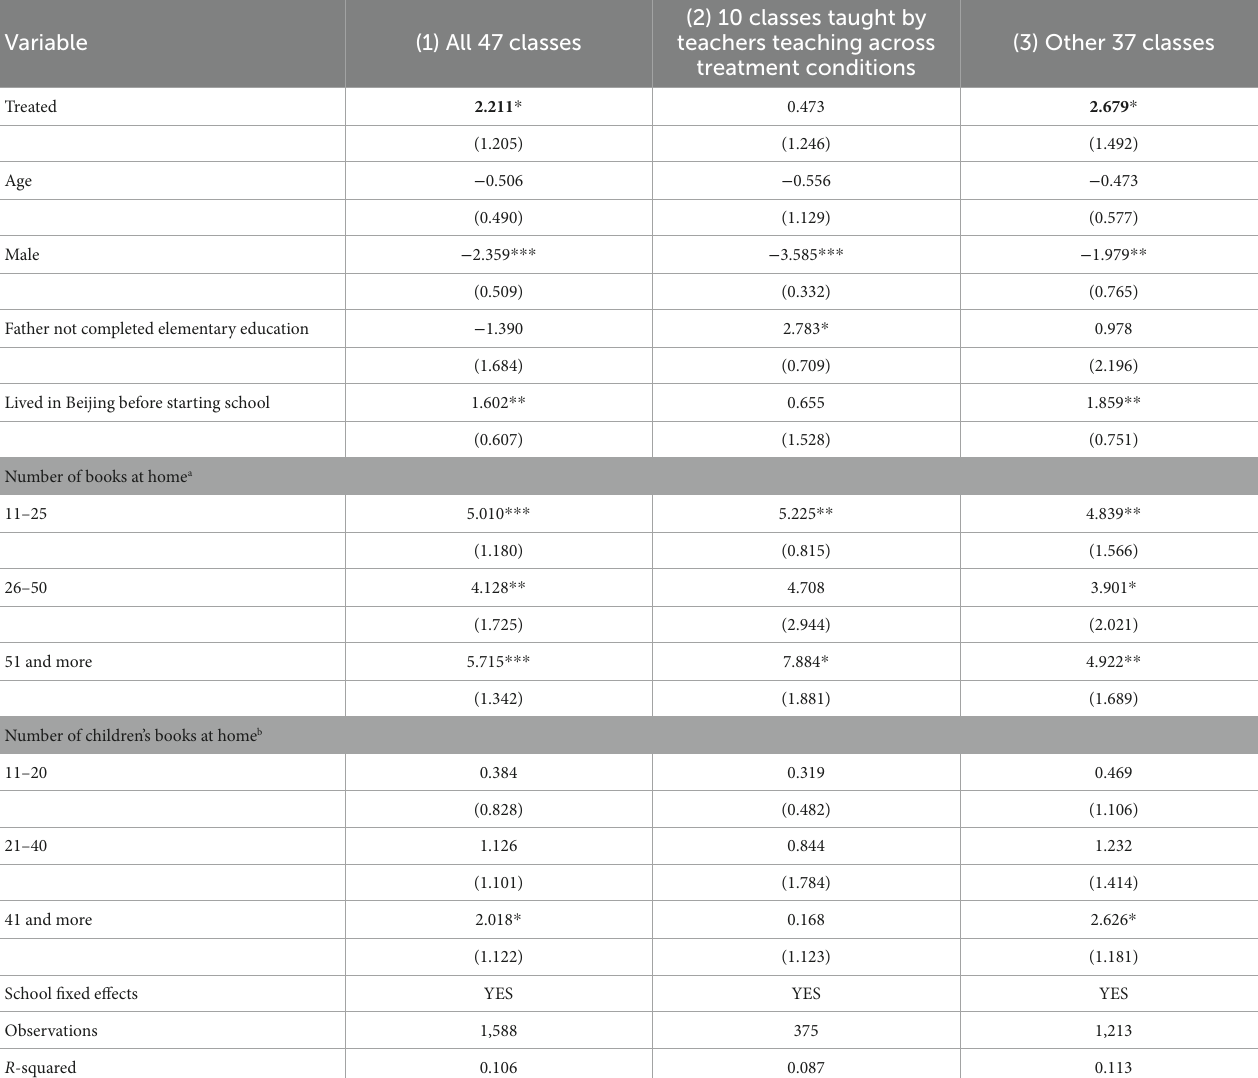
TABLE 2 Effects of the reading instruction program on reading comprehension performance (robust standard errors in parentheses).